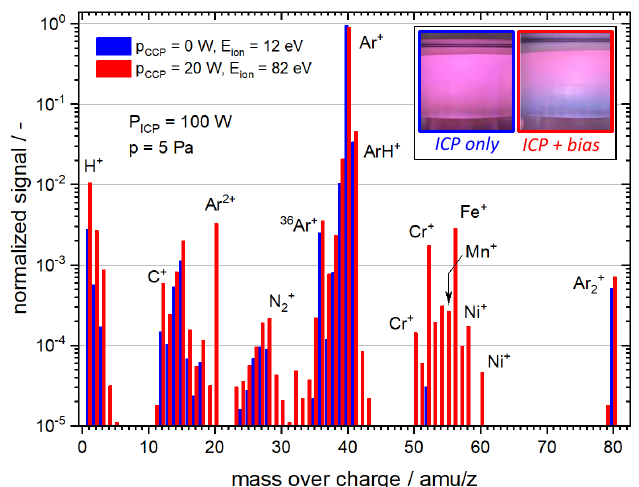
Figure 8. Mass spectrum measured in the ICP without bias (blue bars) at an ion energy of 12eV compared to the mass spectrum measured under the ICP conditions with bias (red bars) measured at an ion energy of 82eV (mean energy of the bimodal peak structure). Inset: photographs of the plasma between the grounded electrode and quartz glass dome for the two measured